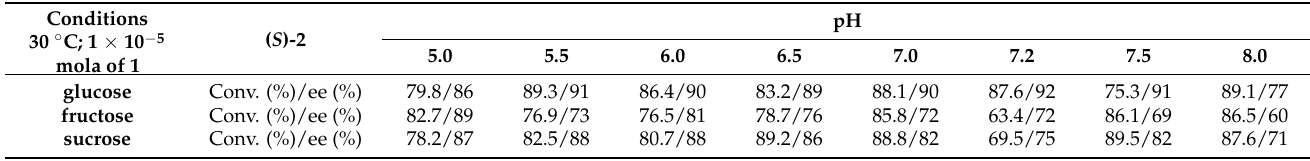
Table 2. The Efficiency and Enantioselectivity of the Bioconversion of 1 by A. pullulans Strain DSM 14940 and DSM 14941 with Fructose and Sucrose as Energy